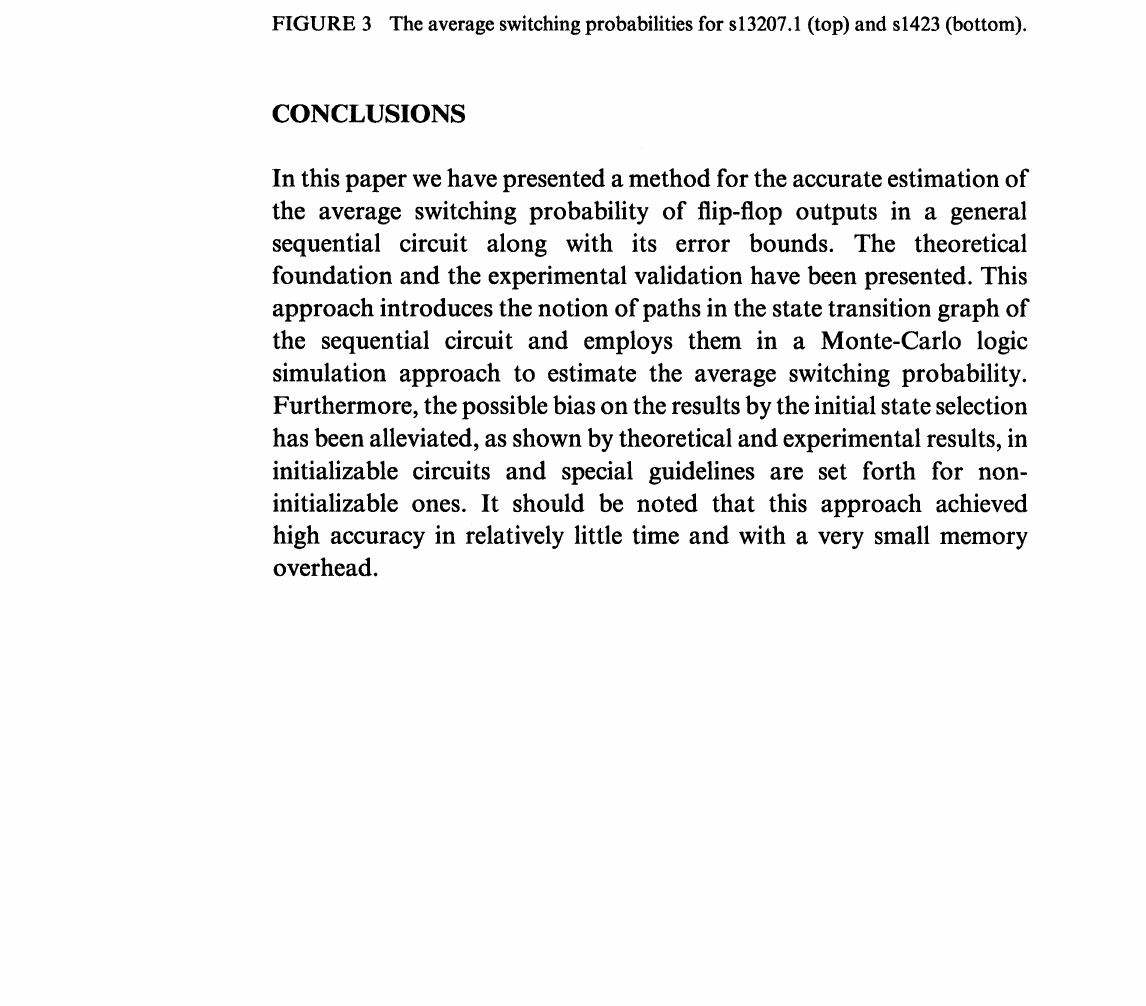
FIGURE 3 The average switching probabilities for s13207.1 (top) and s1423